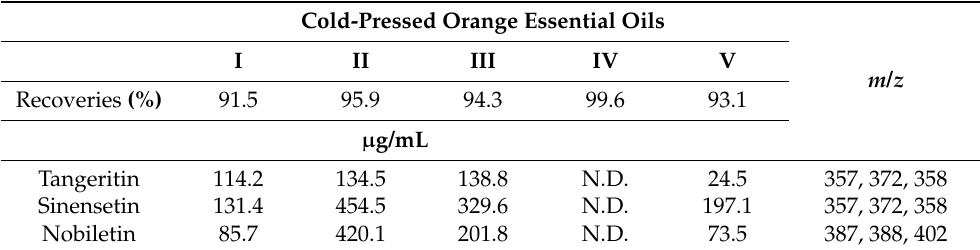
Table 3. The analysis of polymethoxyflavones from cold-pressed orange essential oils by